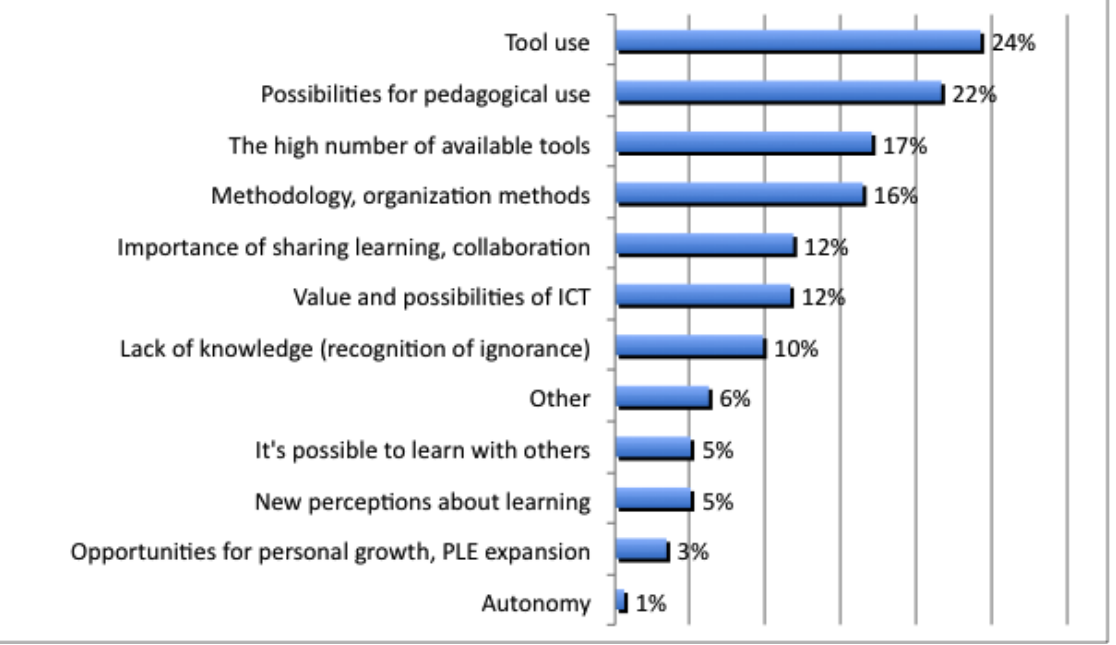
Figure 4. Answers to the question “What was the most important thing you learned in the